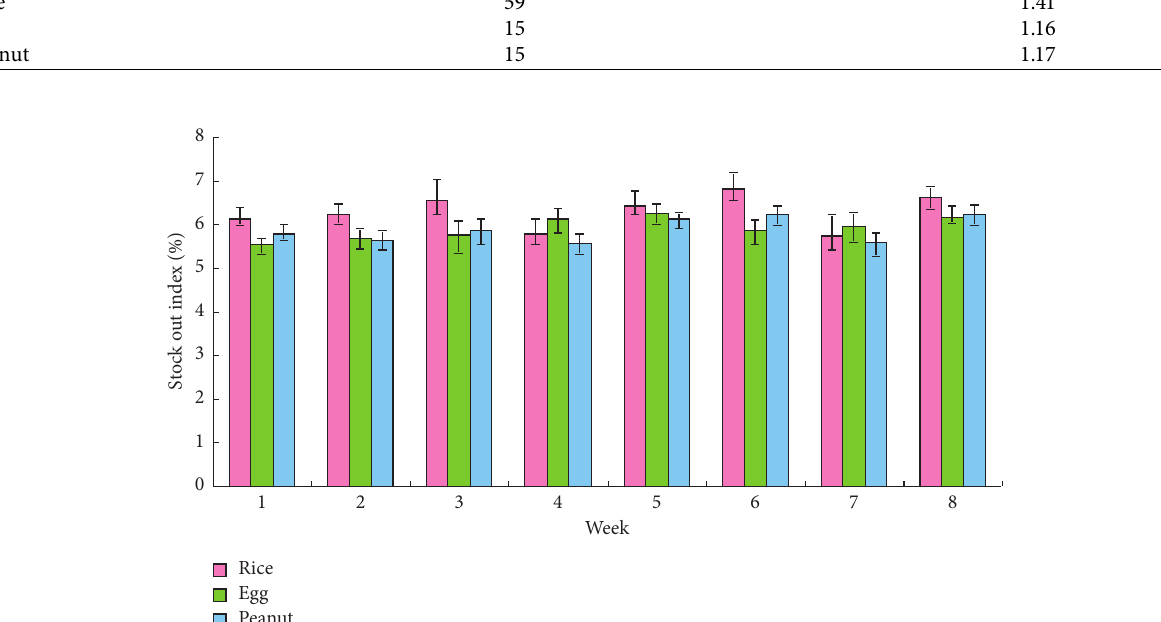
Table 6: Comparison results of inventory shortage and inventory shortage rate of different agricultural products. Agricultural product Average stock-out (kg)